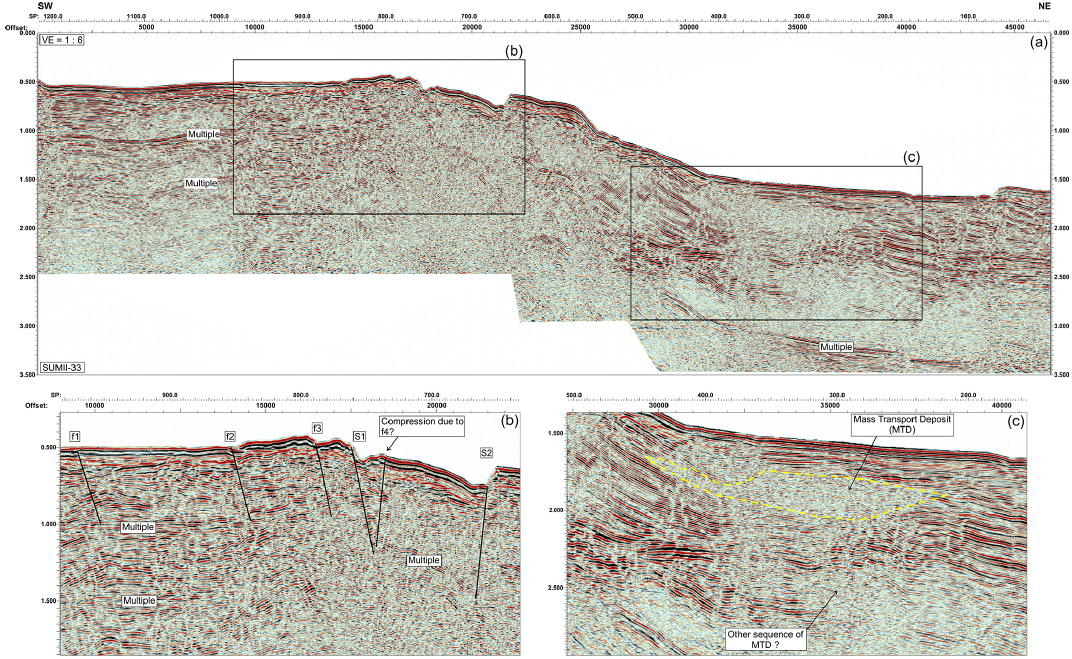
Figure 3. Same as Fig. 2 but for SUMII-33. (a) The reprocess uninterpreted seismic profile with direction, shot point (SP) and offset (in meters) presented at the top of the profile. (b) Possible compression. (c) Mass transport